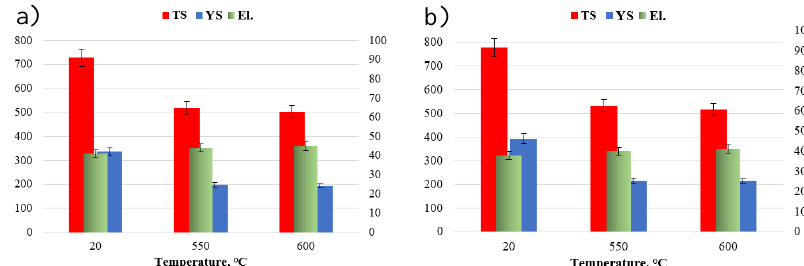
Figure 9. Mechanical properties of HR3C steel in as-received condition ( a ) and after service ( b ); YS— yield strength, TS—tensile strength, and El.—elongation The rise in test temperature results in the reduction in TS value by almost half compared to the as-received condition (Figure 9). Wang et al. [33] reported that at 650 °C fast diffusion could assist dislocation in bypassing